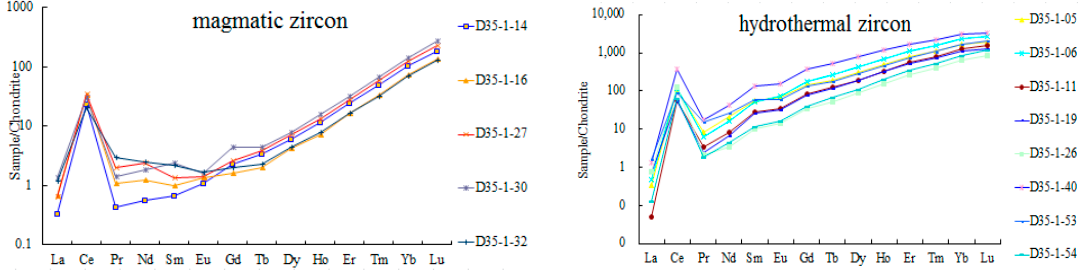
Figure 8. Chondrite ‐ normalized REE patterns of hydrothermal, magmatic zircon.